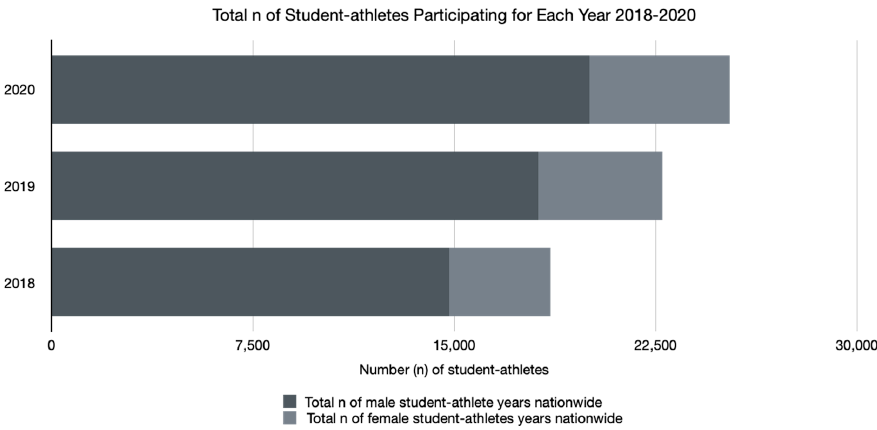
Figure 3. Total number of student athlete-years nationwide for each year (2018–2020). Table 3. 2018–2020 student athlete-years, showing a consistent proportion of male and female stu- dent athletes.